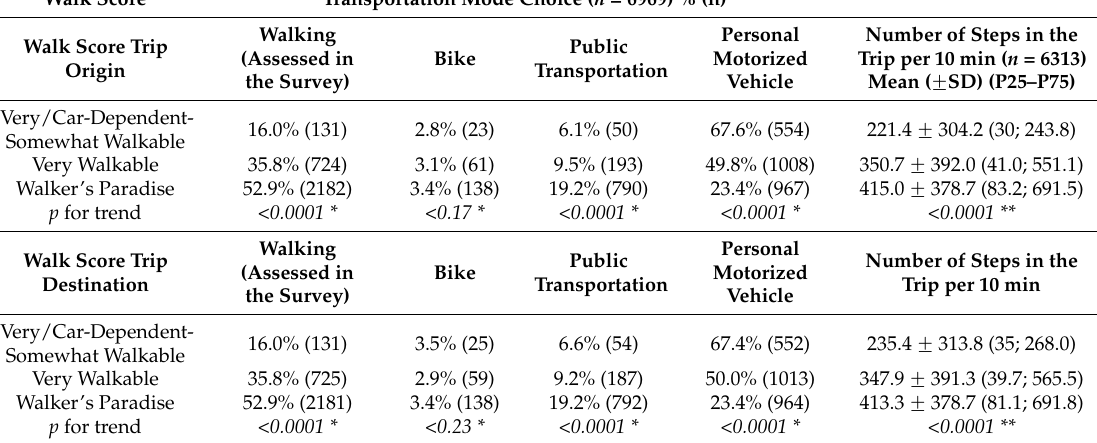
Table 2. Distribution of transportation mode choice and walking according to the Walk Score (at the trip